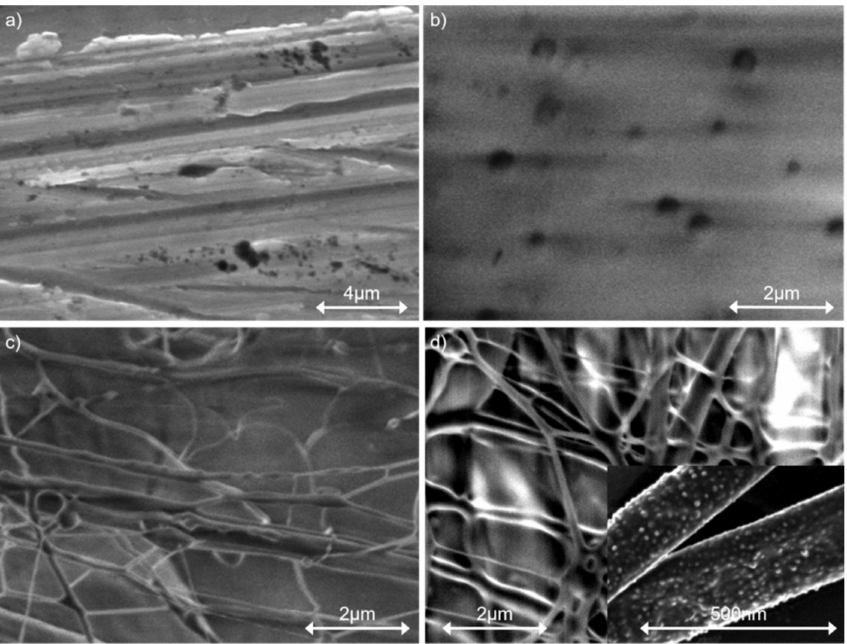
Figure 1. Morphologies of samples: ( a ) TiZr; ( b ) TiZr / PLA; ( c ) TiZr / PLA-PCL; ( d ) TiZr / PLA-PCL + Ag-NPs; inset - higher magnification of TiZr / PLA-PCL + Ag-NPs